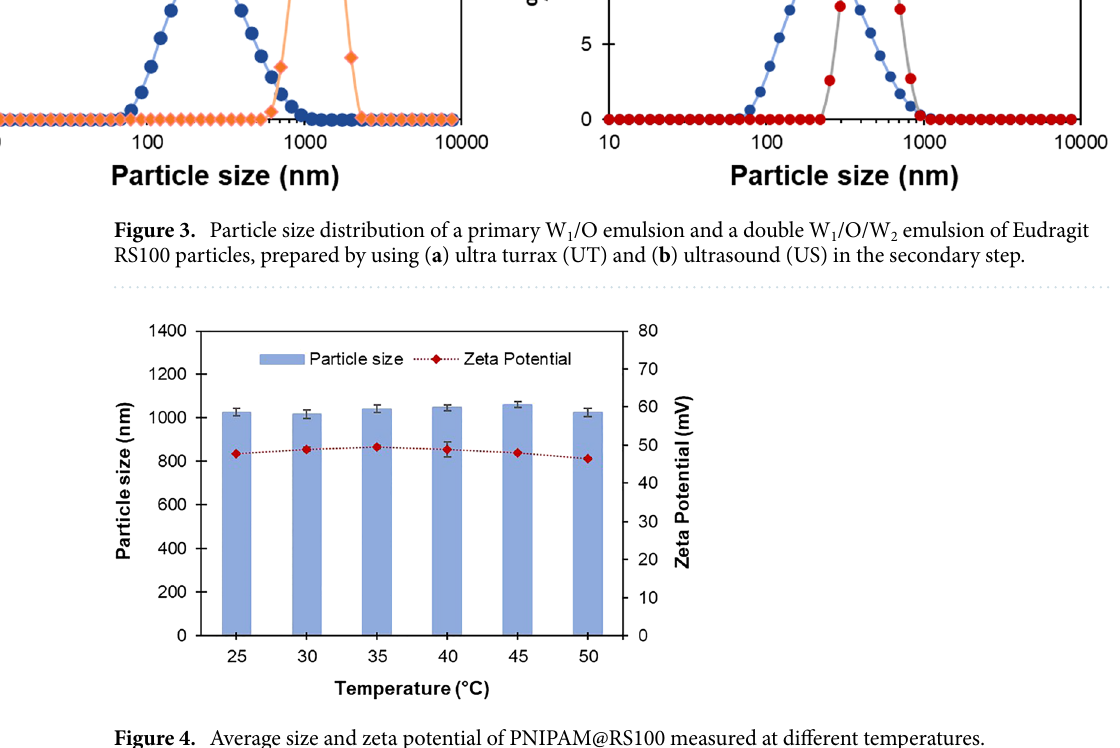
Figure 4. Average size and zeta potential of PNIPAM@RS100 measured at different